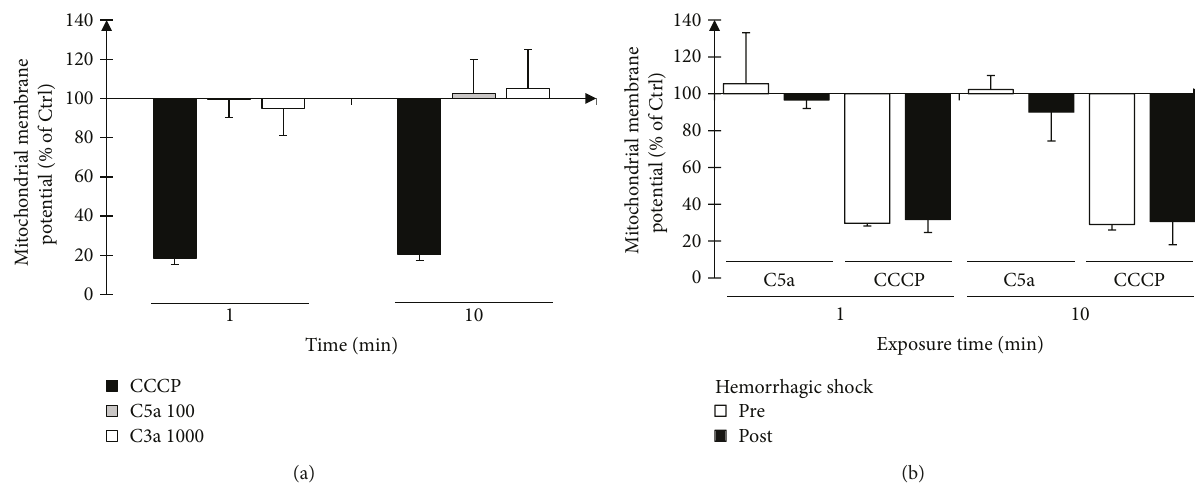
Figure 5: (a) Measurement of mitochondrial membrane potential of human PMN. No signi fi cant change in mitochondrial membrane potential occurred when human PMN are stimulated with C5a or C3a. In contrast, the potent uncoupler CCCP can e ff ectively alter the mitochondrial membrane potential ( n = 6 ; 5 ; 4 ). (b) Mitochondrial membrane potential before and after hemorrhagic shock. While C5a does not alter the mitochondrial membrane potential, the breakdown conjured by CCCP remains nearly the same ( n = 3 -4).